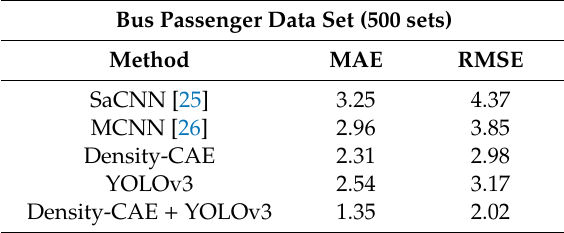
Table 1. Performances of di ff erent methods for the bus passenger dataset.